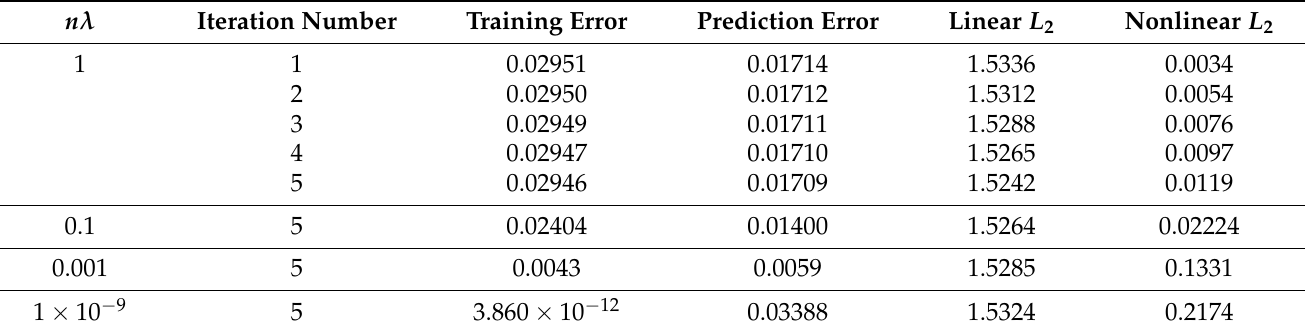
Table 3. Simulation results when (cid:101) ∼ N ( 0,0.1 ) . The third column shows the mean squared prediction error on the training points. The fourth column shows the mean squared prediction error on the testing points. The fifth column and the last column show the approximated L 2 norm of ˆ f and ˆ g as in (20), respectively.